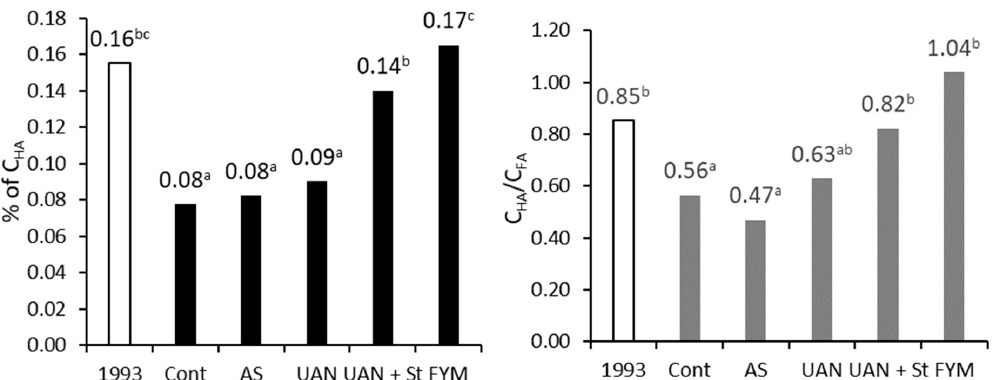
Figure 5. Content of humic acids (C HA ) and their ratio to fulvic acids (C FA ); topsoil; different letters behind the values mean significant differences among investigated treatments (Tukey test; p < 0.05); number of replications per treatment n = 4.